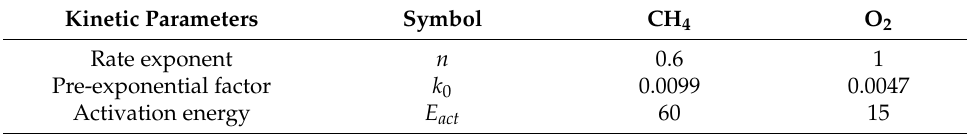
Table 1. Kinetic parameters of Cu/CuO reaction with CH 4 and O 2